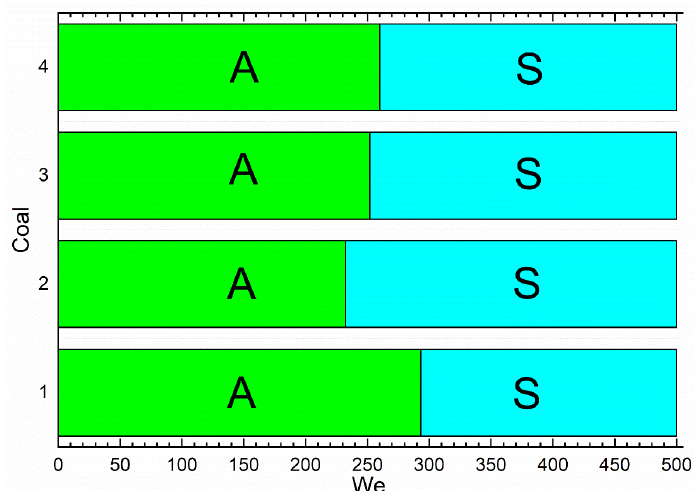
Figure 16. Interaction regime maps for distilled water droplets colliding with carbonaceous substrates (pressed pellets) when varying coal rank and R d = 1.4 mm: 1 — filter cake of coking coal; 2 — brown coal; 3 — coking coal; 4 — anthracite. A — agglomeration; S — separation. It is possible to control the constant size and density of pellets from ground coal.